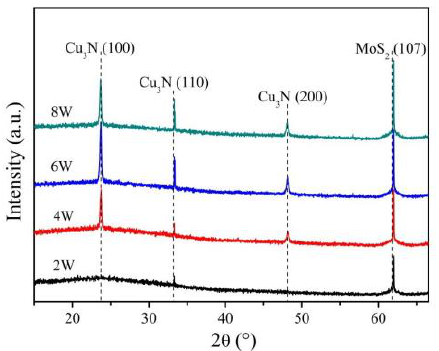
Figure 1. XRD spectra of Cu 3 N/MoS 2 composite films with different sputtering powers.